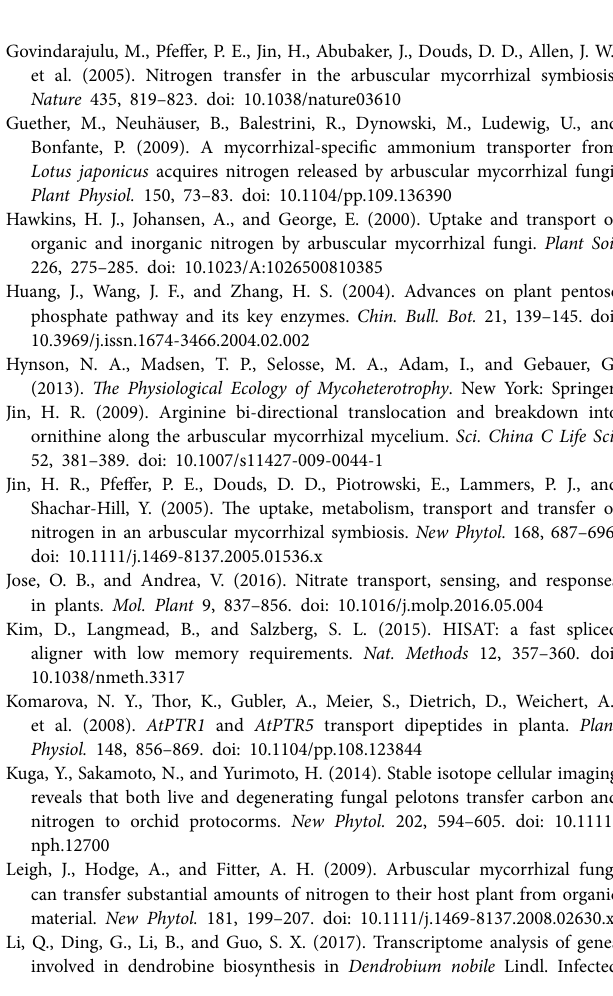
Supplementary Table T2 | Statistical results of sequencing data. Supplementary Table T3 | Differentially expressed